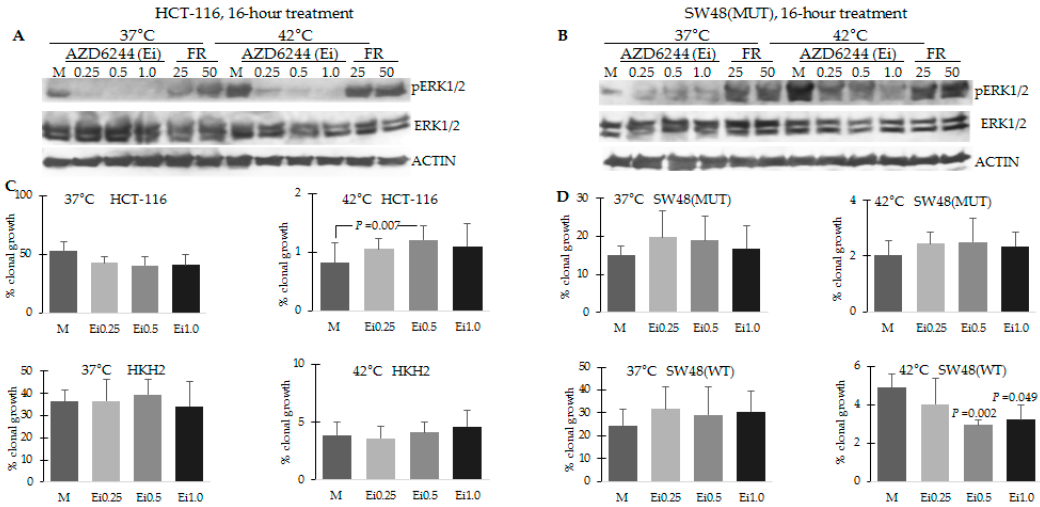
Figure 3. Hyperthermia ‐ induced ERK activity has anti ‐ proliferative effects in mutant KRAS CRC cells. ( A , B ) Cells were exposed for 16 h to 37 °C or 42 °C, and mock treatment (M), AZD6244 at 0.25, 0.5 and 1.0 μ M, or FR180204 (FR) at 25 and 50 μ M. Total cell lysates were analyzed by Western blotting, and probed for total ERK1/2, phosphorylated (p) ERK1/2 and ACTIN as described in Figure 2; ( C , D ) (Ei) at 0.25, 0.5 and 1.0 µ